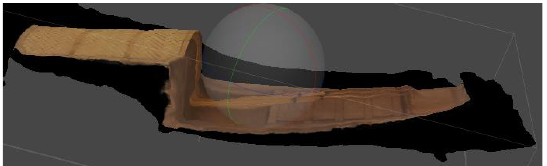
Figure 6a. Small Junk Model creating using Cell phone Images Agisoft